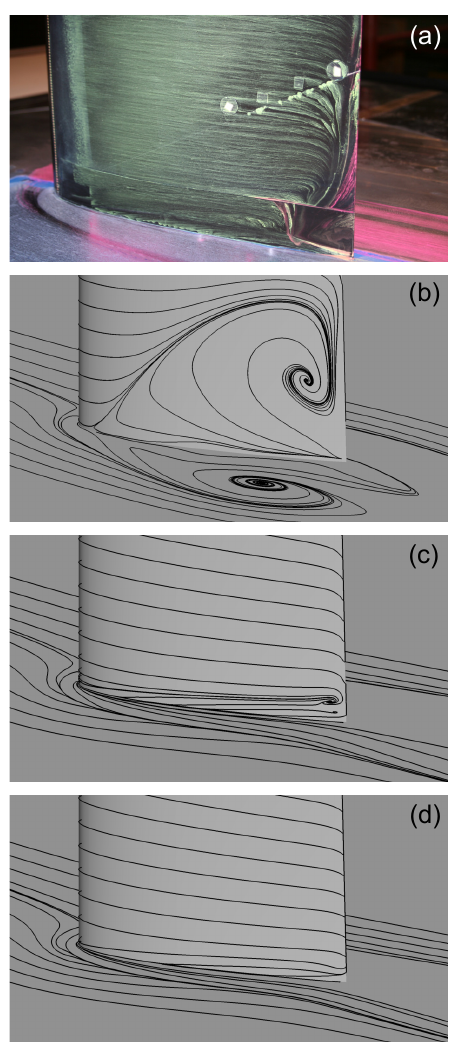
Figure A1. Visualization of corner separation for the simplified wing–body junction experiment of Gand et al. (2015) (a) . Predic- tion with SA (b) , SST (c) and RSM (d) . Figures reproduced from simulations of Przewlocki